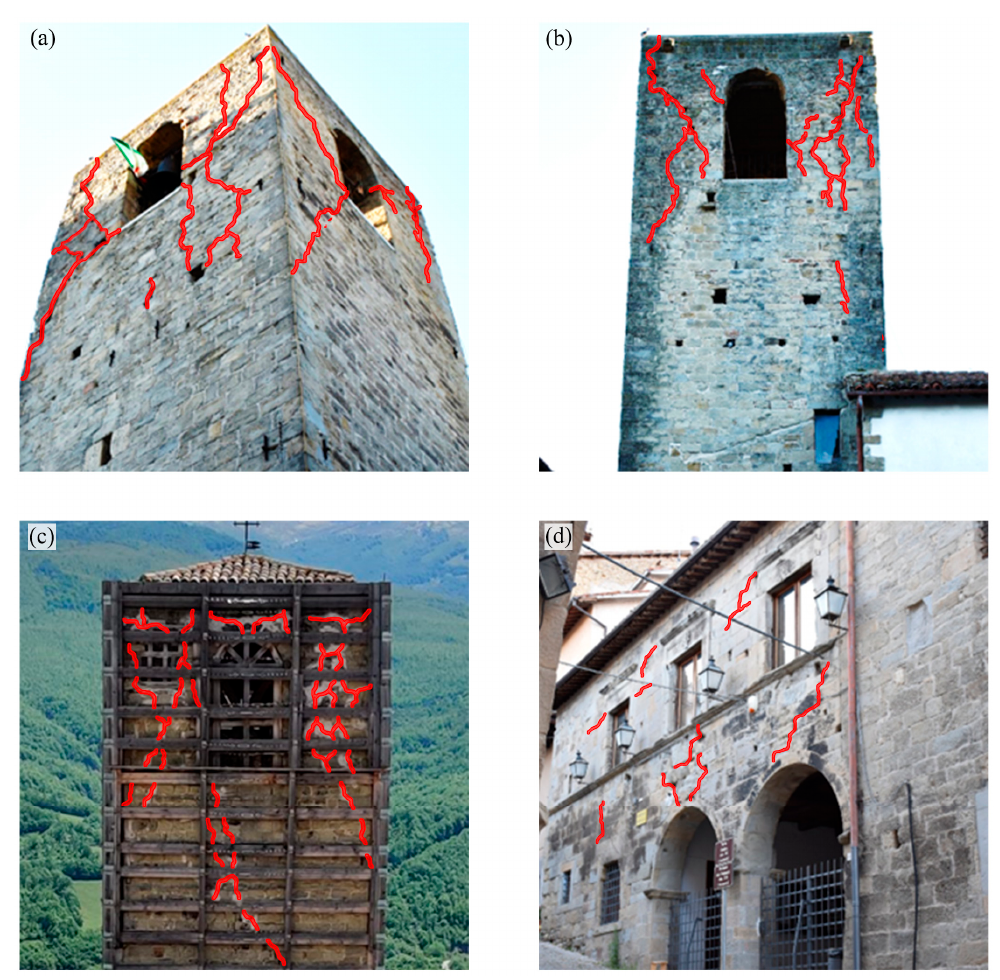
Figure 3. Damage suffered by the structure following the Central Italy Earthquakes. Bell cell ( a ) south-east, ( b ) north, ( c ) west façade, and ( d ) Podestà Palace south façade. Before the last strong quake occurred on 30 October 2016, the firefighters secured it. They enclosed the tower with a system of ties and wood elements to avoid its collapse if other strong quakes would have occurred (Figure 3).